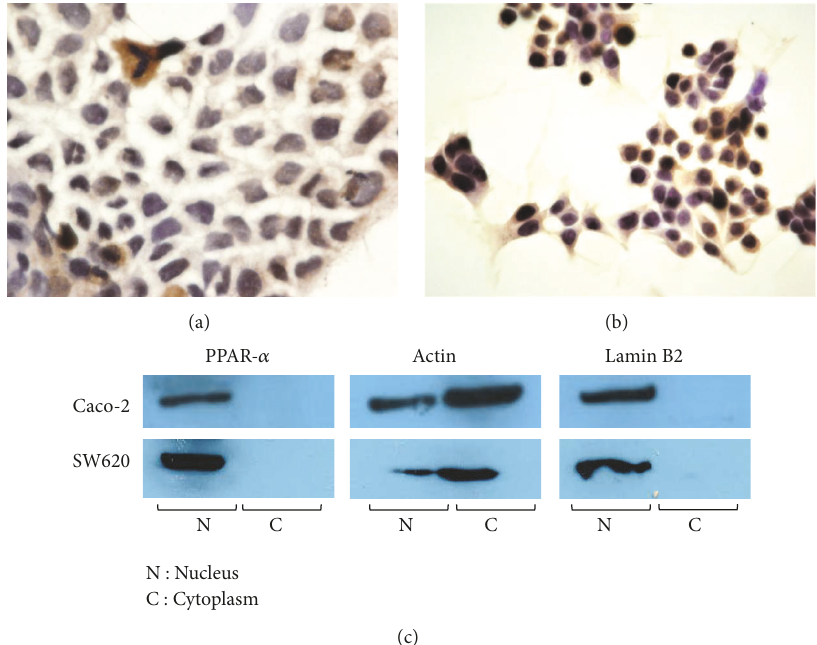
Figure 2: Localization of PPAR- 𝛼 in Caco-2 and SW620 cells. (a, b) Immunocytochemical staining of PPAR- 𝛼 in Caco-2 and SW620 cells. (c) PPAR- 𝛼 was expressed in the nucleus of Caco-2 and SW620